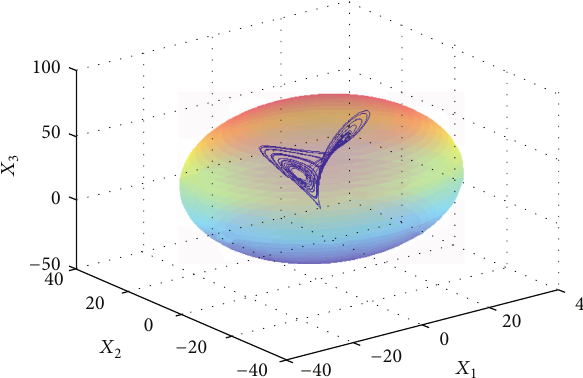
Figure 1: The chaotic attractor of system (1) with 𝑎 = 25 , 𝑏 = 16 , 𝑐 = 40 , 𝑑 = 4 , 𝑒 = 5 , 𝑓 = 5 , and 𝑔 = 7 and its ultimate bound with = 1.2 , 𝑝 = 1.7 , and 𝑝 = 0.5 . 𝑝 11 22 33 (2𝑒/𝑔)(𝑏𝑝 + 𝑐𝑝 ) − 2𝑒𝑝 𝑐 = 0 . Then, system (1) 11 22 33